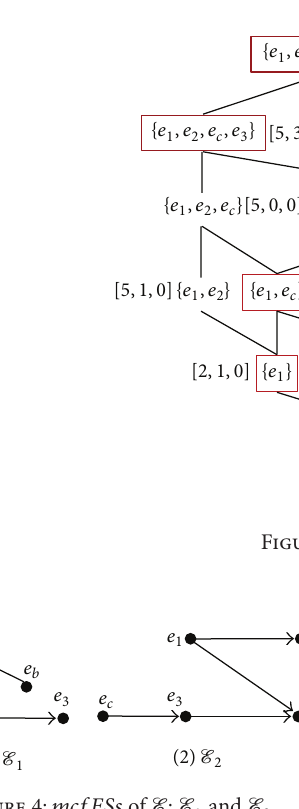
Figure 4: 𝑚𝑐𝑓𝐸𝑆𝑠 of E : E 1 and E 2 .